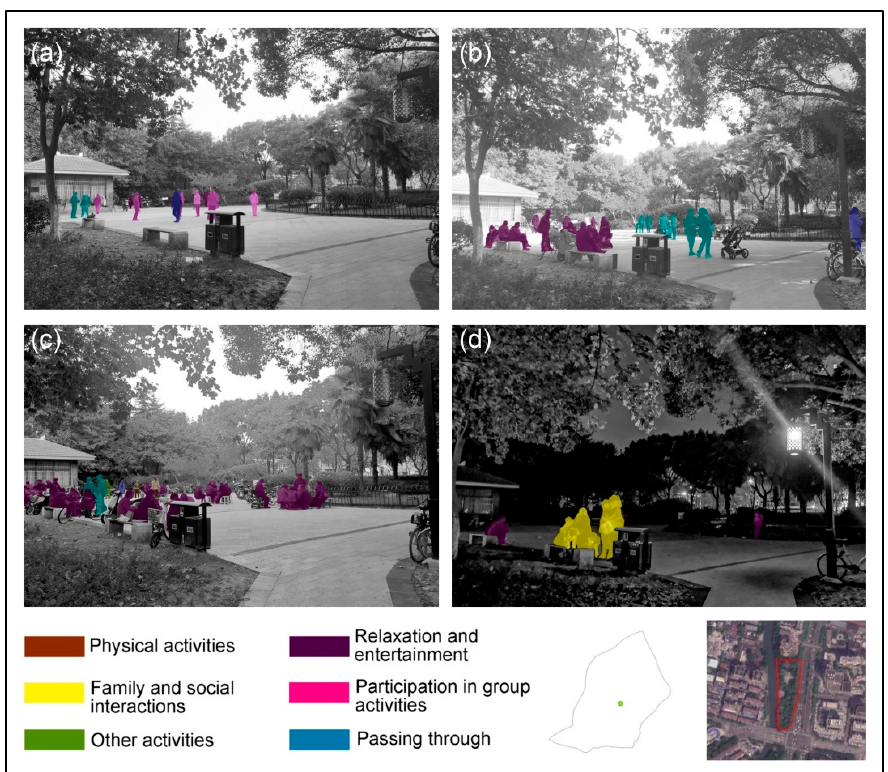
Figure 2. The use of pocket park sample No. 28 on 13 November 2020 (weekday, sunny, 16 °C